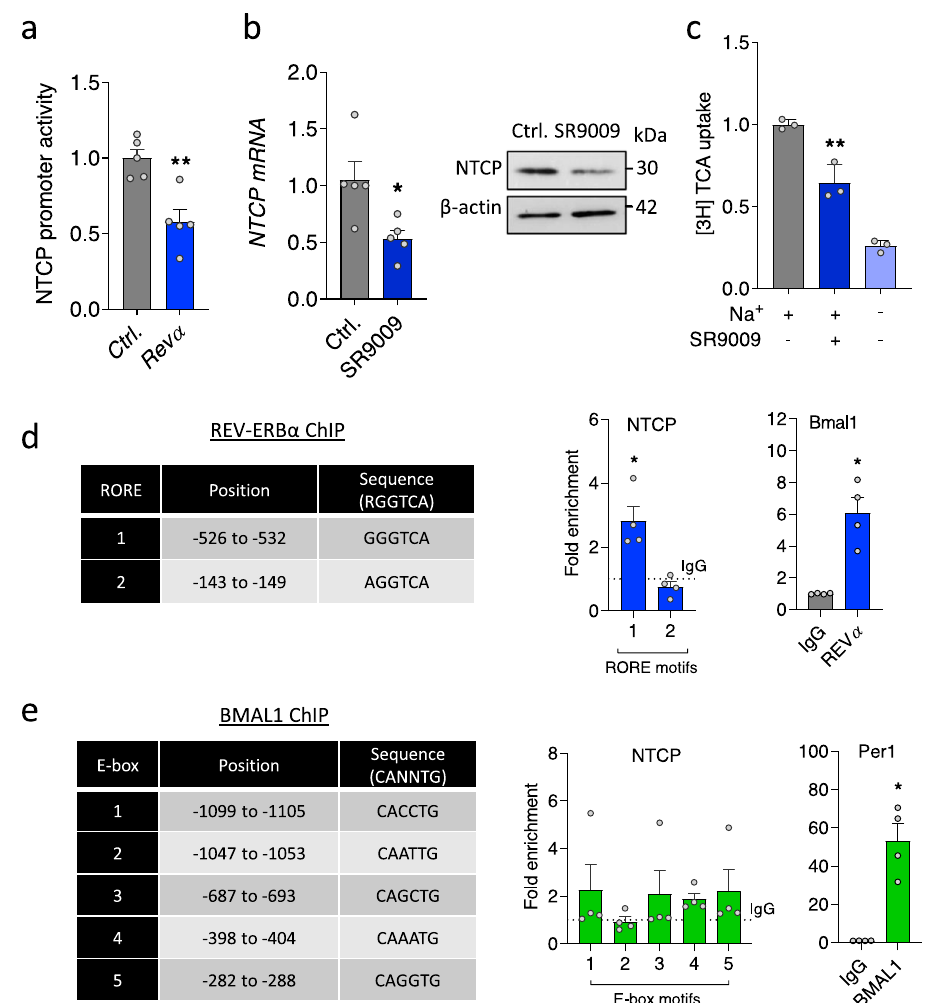
Fig. 2 Direct role for REV-ERB α to bind and regulate NTCP. a HepaRG cells were co-transfected with NTCP promoter luciferase reporter ( − 1kb) and control or Halo-tagged Rev-Erb α expression plasmid. NTCP promoter activity was determined 48 h later by quantifying luciferase activity and data expressed relative to control (mean ± SEM, n = 5, Mann – Whitney test, Two-sided). b dHepaRG cells were treated with SR9009 (20 µ M) for 24 h and NTCP RNA and protein measured along with the housekeeping β -actin by qRT-PCR or western blotting (mean ± SEM, n = 5, Mann – Whitney test, Two- sided). c dHepaRG cells were treated with SR9009 (20 µ M) for 24 h; [3H]-taurocholic acid was supplied with media for 10 min; intracellular radioactivity was measured by liquid scintillation counting and data expressed relative to control (mean ± SEM, n = 3, One-way ANOVA with multiple comparisons, Two-sided). Coordinates of RORE or E-box motifs in NTCP promoter. Chromatin extracts from HepaRG cells were immunoprecipitated using antibodies speci fi c for REV-ERB α ( d ), BMAL1 ( e ) or rabbit IgG as a negative control. PCR for NTCP promoter regions using primers targeting de fi ned RORE or E-box motifs and control host genes Bmal1 or Per1 was performed and %IP data presented relative to a rabbit IgG control shown as the dotted line (mean ± SEM, n = 4, Mann – Whitney test, Two-sided). * p < 0.05, ** p < 0.01. Data are provided in the accompanying Source Data fi